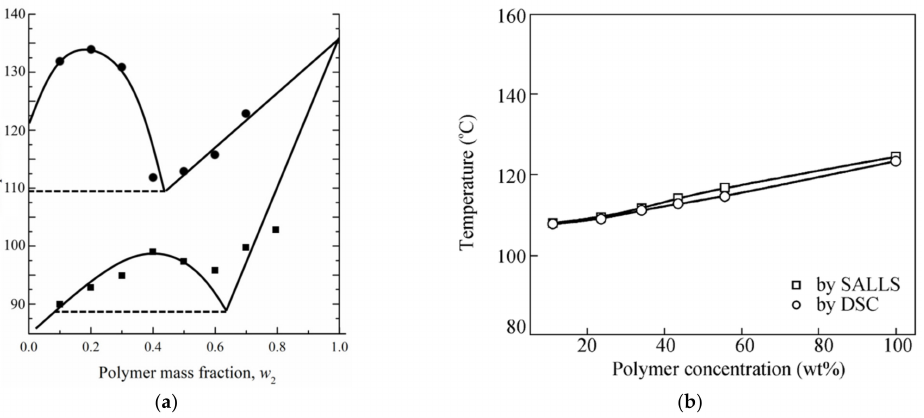
Figure 6. Phase diagrams for UHMWPE mixtures with ( a ) diphenyl ether (circles) and decaline (squares) [230] and ( b ) LP [198]. Figure 6a is reproduced with permission from H. Ding, Y. Tian, L. Wang, B. Liu, Journal of Applied Polymer Science; Published by “John Wiley and Sons”, 2007. Figure 6b is reproduced with permission from L. Shen, M. Peng, F. Qiao, J.L. Zhang, Chinese Journal of Polymer Science, Published by World Scientific, 2008.